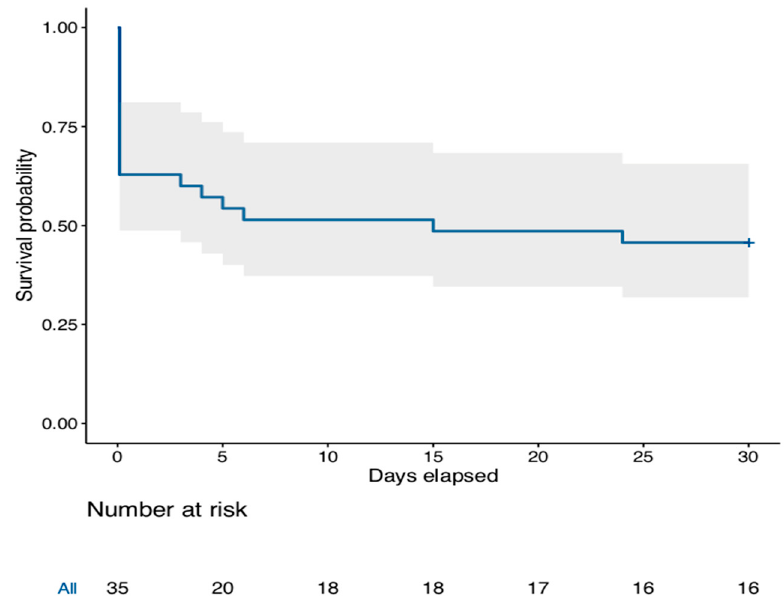
Figure 1. Kaplan–Meier curve showing the probability of survival over time.